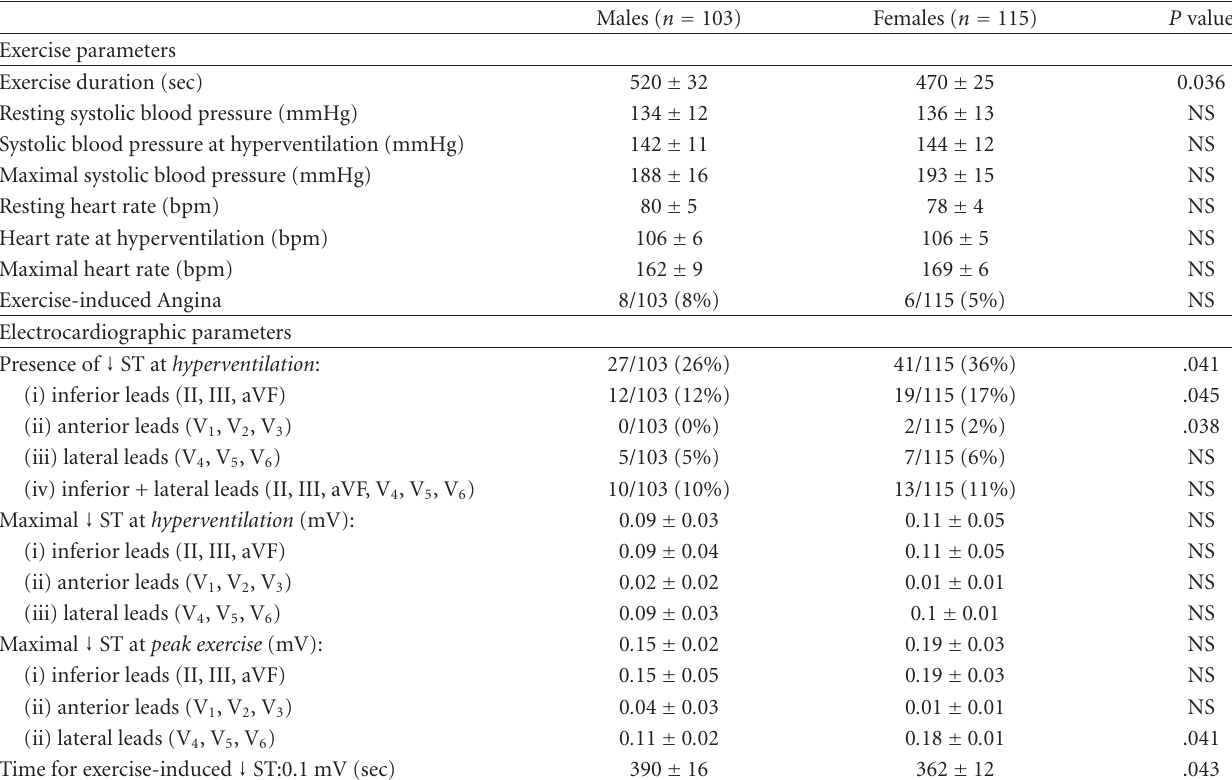
Table 2: Exercise and electrocardiographic